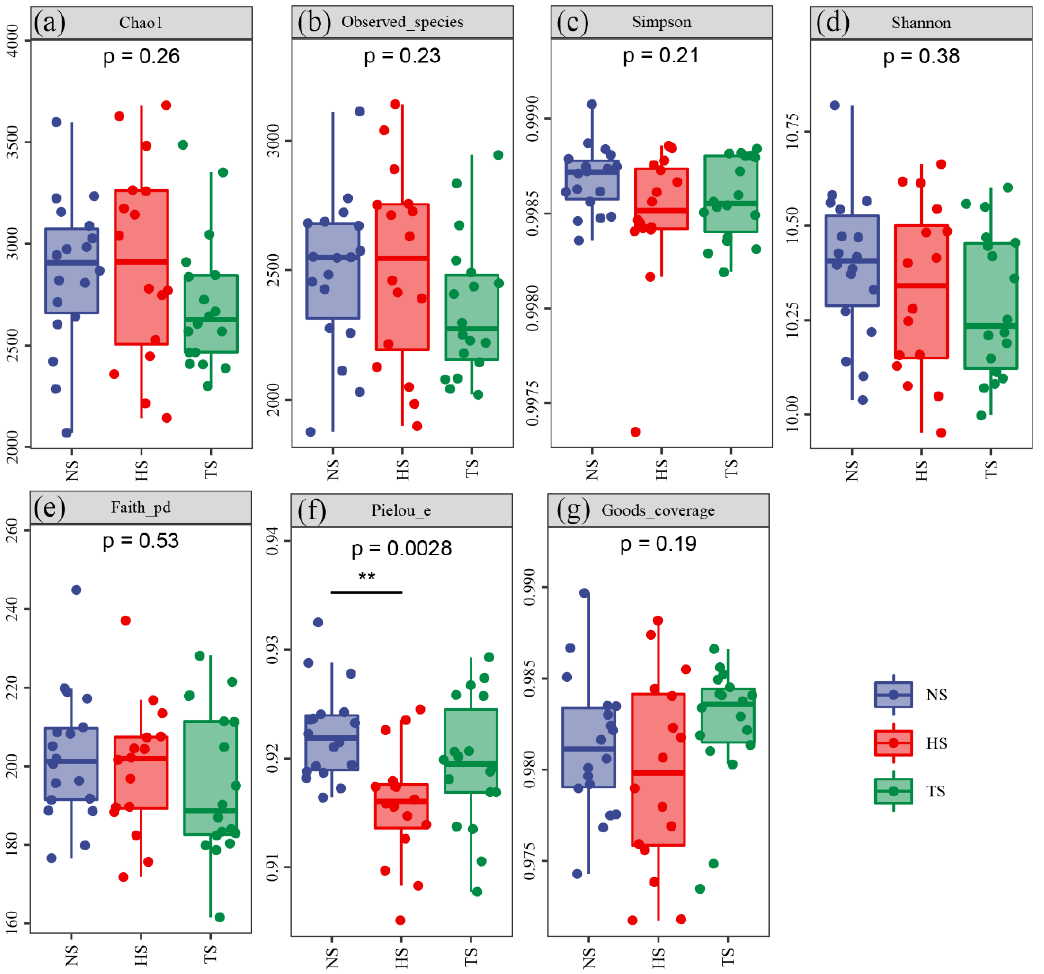
Figure 4. Effect of different fertilizer and straw applications on bacterial diversity based on chao1, Shannon, and Simpson indices. ( a ), Chao1; ( b ), Observed species; ( c ), Simpson; ( d ), Shannon; ( e ), Faith ’s PD; ( f ), Pielou e; ( g ), Good ’s coverage. Significant differences are denoted by ** p < 0.01).